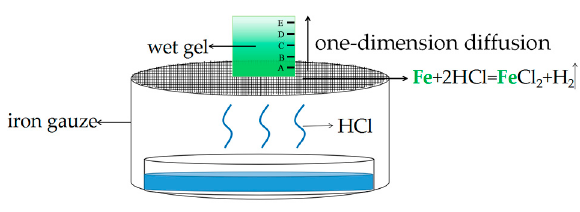
Figure 1. The schematic diagram of the 1d diffusion preparation of gradient Fe(II)/SiO 2 gels.